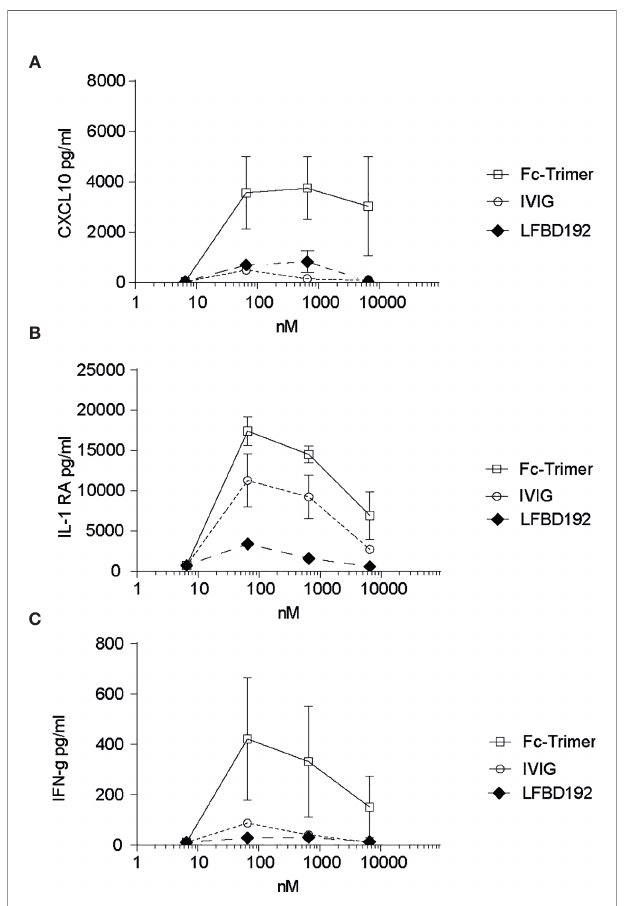
FIGURE 5 | LFBD192 does not trigger cytokine release. Cytokine release in human whole blood was determined by multiplex immunoassay after incubation with LFBD192, the Fc-trimer, and IVIg at 6.5, 65, 650, and 6,500 nM. The pro- in fl ammatory cytokines G-CSF, IL-1 b , IL-12/p70, TNF- a , CXCL9/MIG, and IL-6 and the anti-in fl ammatory cytokines IL-4, IL-5, IL-10, and IL-22 were not detected. The detected cytokines were CXCL10 (A) , IL-1RA (B) , and IFN g (C) . Data represent the means ± SEM of two experiments from two human donors, each experiment performed in